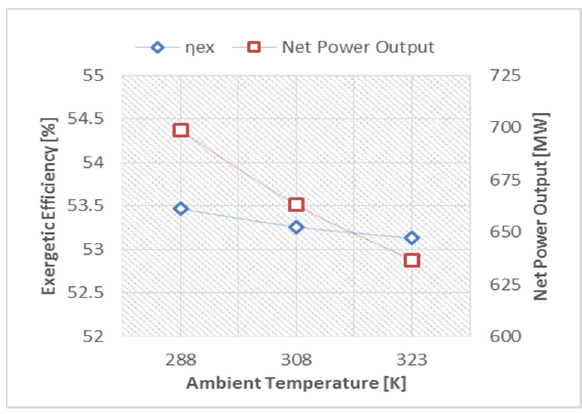
Figure 2. Exergetic efficiency and block net power output verses ambient temperatures.